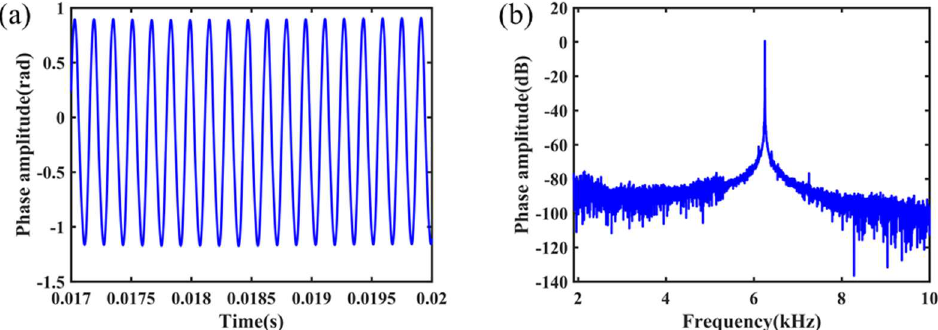
Figure 5. The modulation frequency of OM phase modulator is 6.25 kHz; the system demodulated the signal in ( a ) time domain and ( b ) frequency domain.